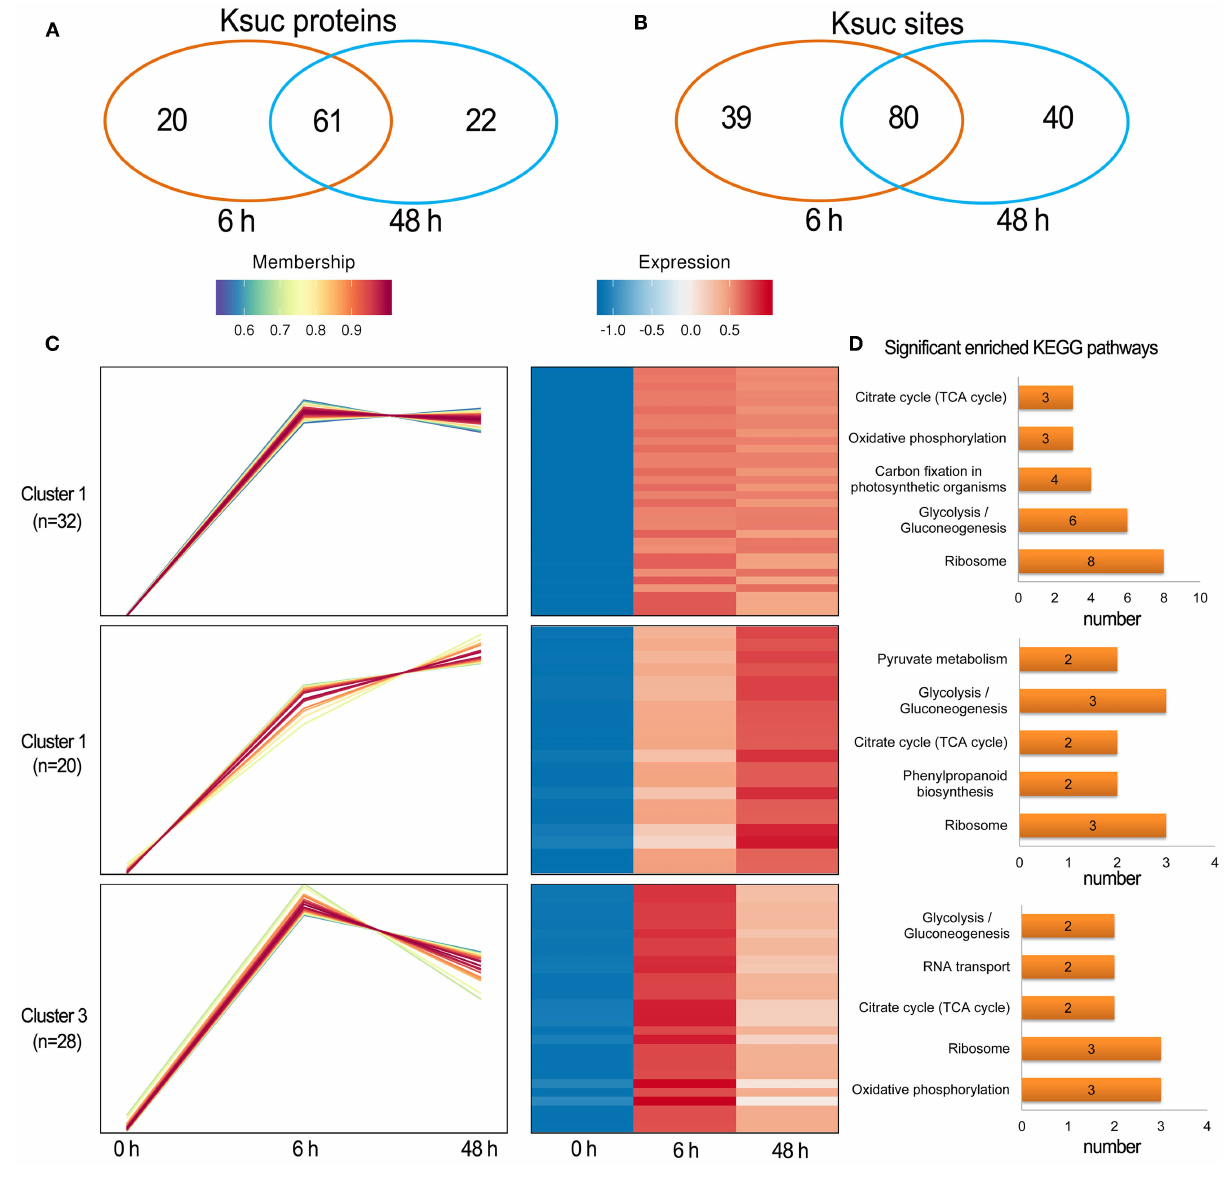
Frontiers in Plant Science |